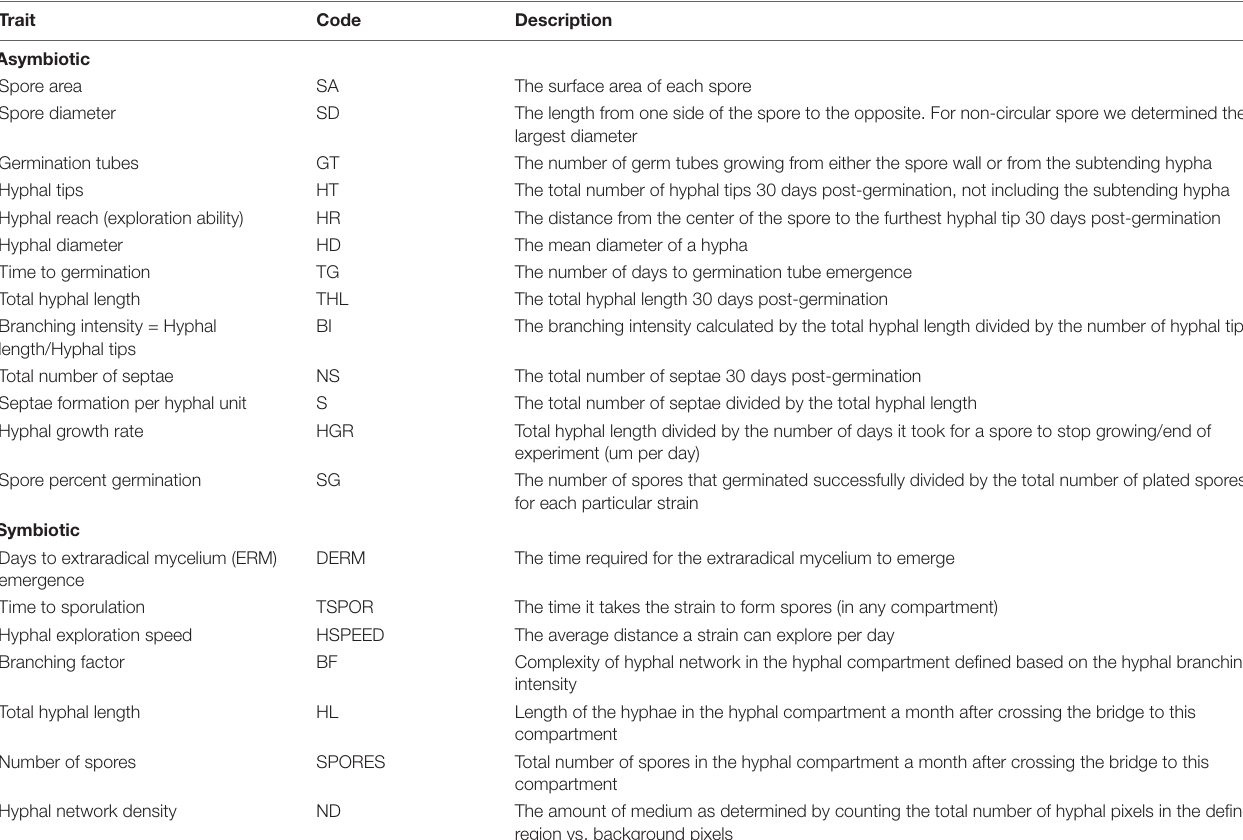
TABLE 1 | Life history traits (LHTs) measured in two experiments along with the abbreviation and the description of each trait. Trait Code